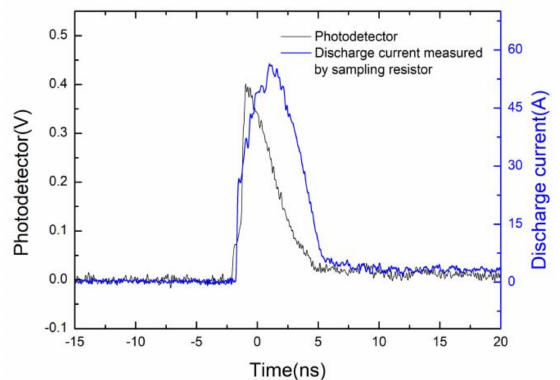
Figure 8. The comparison between the discharge current waveform measured by sampling resistor and the laser pulse waveform detected by the